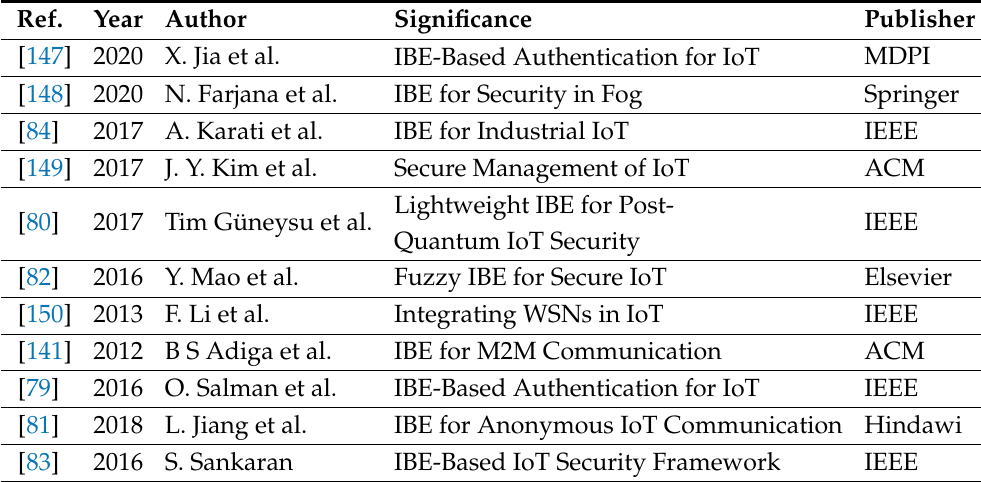
Table 3. Significant IoT-related literature for IBE in the last decade.